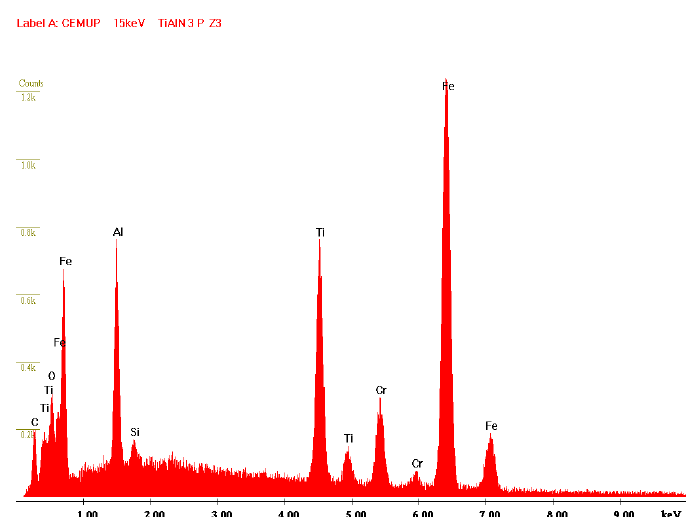
Figure 11. SEM image collected on the coated ring surface after tinplate contact during the wear tests.